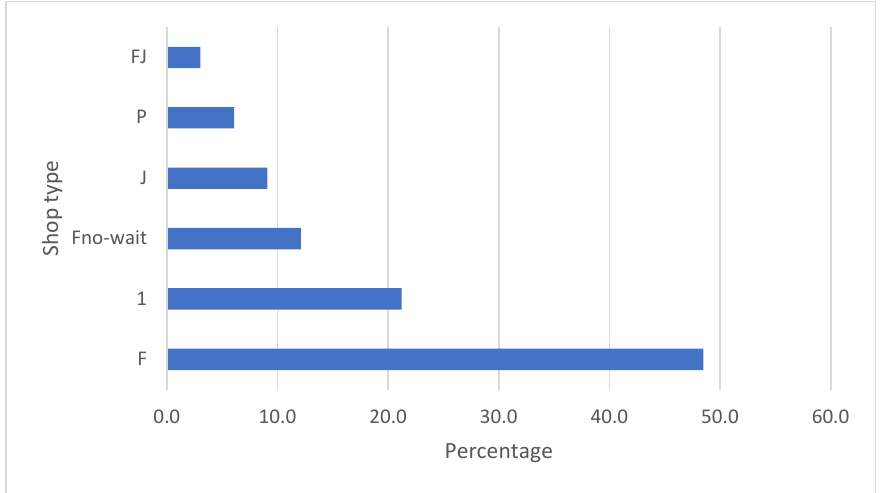
Fig. 2. Percentage of addressed problems with respect to shop